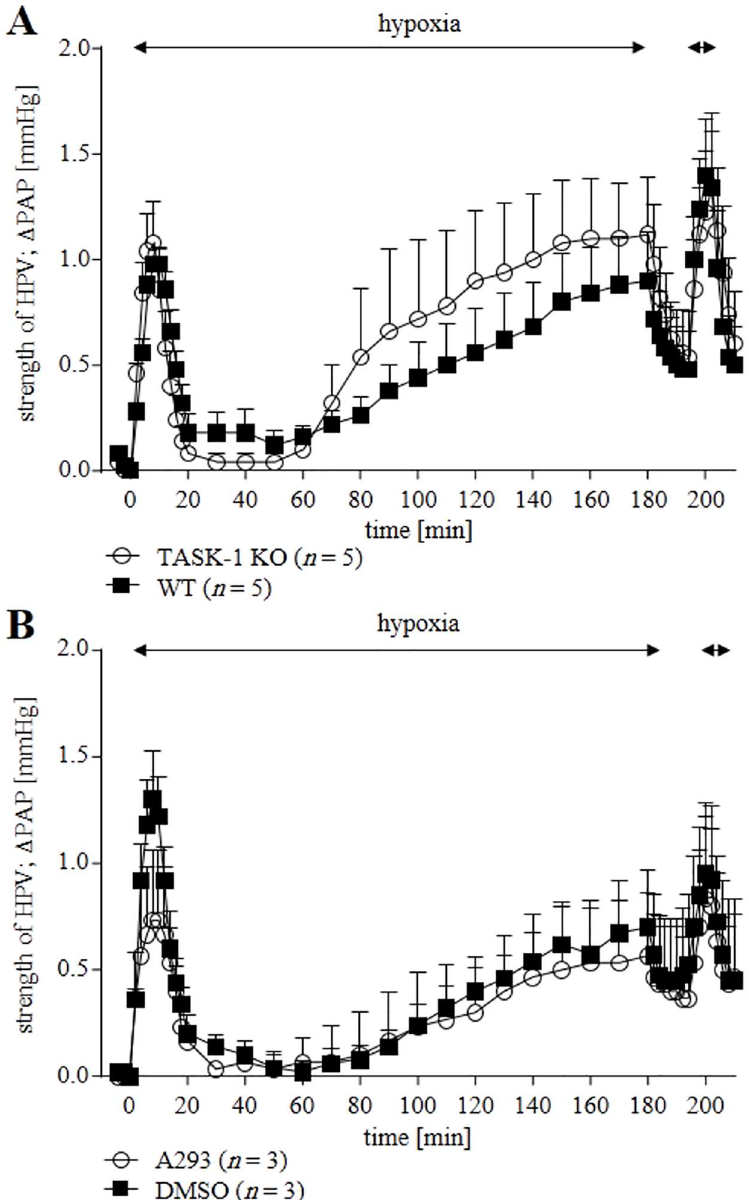
Fig 7. Hypoxia-induced changes in Pulmonary Arterial Pressure( Δ PAP) of isolated, perfused, and ventilated lungs of WT and TASK-1 KO mice. Δ PAP was referencedto the onset of 180 min of hypoxic ventilation period(time set at 0). Normoxic PAP and its increase duringhypoxic ventilation were neither different between KO and in WT mice (A) nor when comparing WT mice in the presence or absenceof the TASK-1 inhibitorA293 (B) . Data are presented as mean ± SEM. n refers to number of animalsused. HPV: hypoxic pulmonary